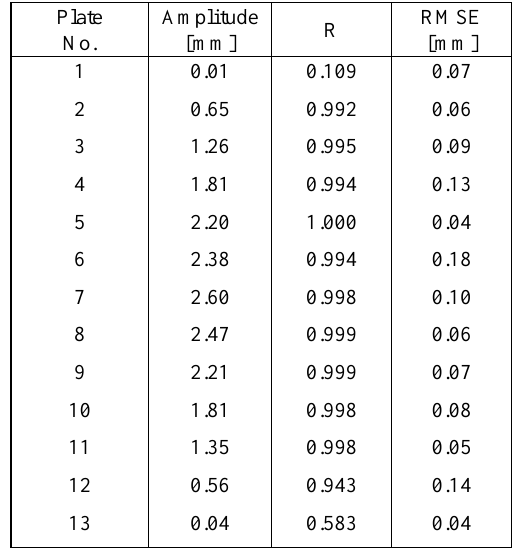
Table 7. Estimated amplitude, Pearson’s coefficient, and